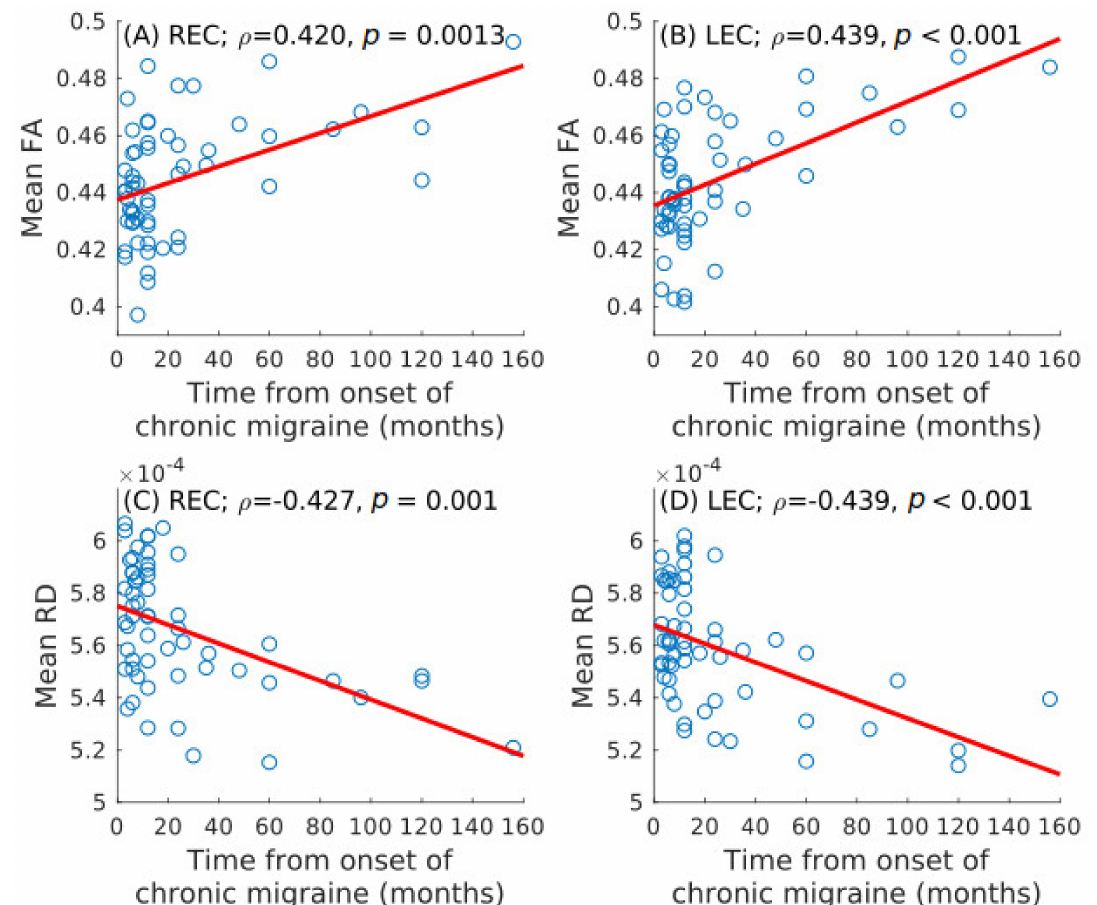
Figure 6. Spearman correlation values between the time from onset of CM and di ff usion measures. Statistically significant positive association with the mean fractional anisotropy (FA) in the bilateral external capsule is shown in ( A ) and ( B ). Statistically significant negative association with the mean radial di ff usivity (RD) is shown in ( C ) and ( D ). LEC = left external capsule; REC = right external